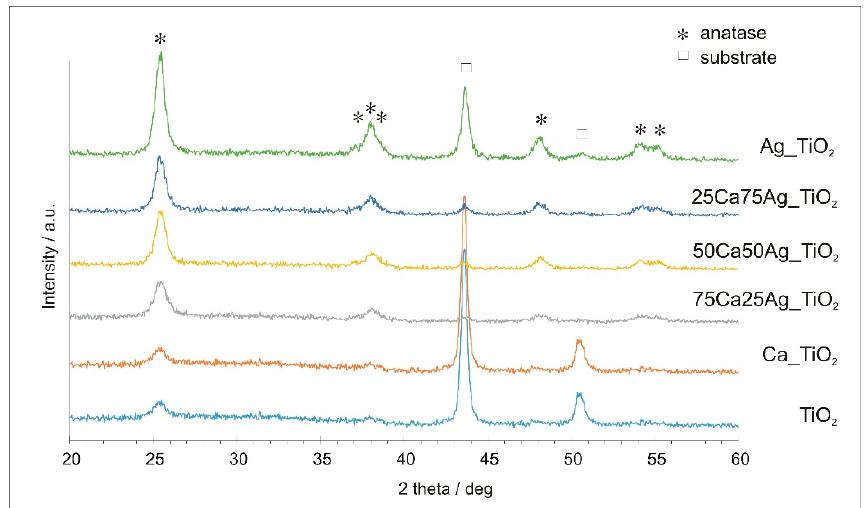
Figure 2. XRD patterns for TiO 2 -based coatings doped with Ca and Ag ions in different molar ratios.